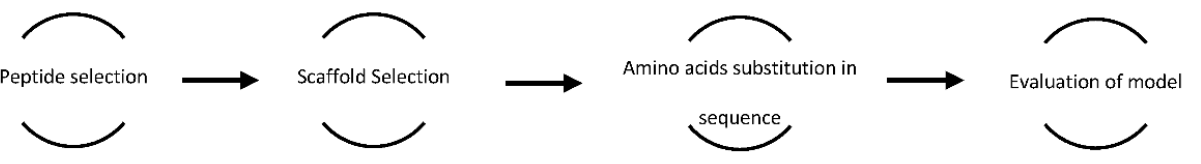
Figure 1. Stages followed to design a protein against metabolic syndrome.